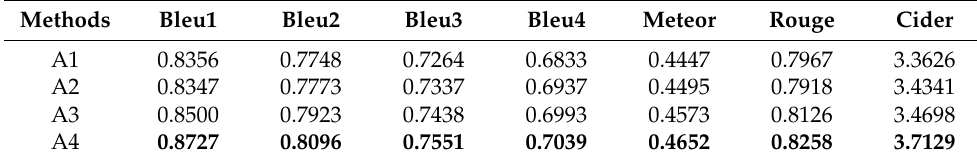
Table 5. Ablation performance of our designed model on the UCM-Captions data set [33]. Methods